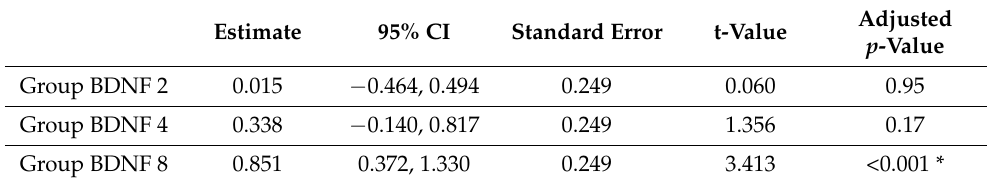
Table 5. Interaction analysis between the two groups (Change from BDNF 0).